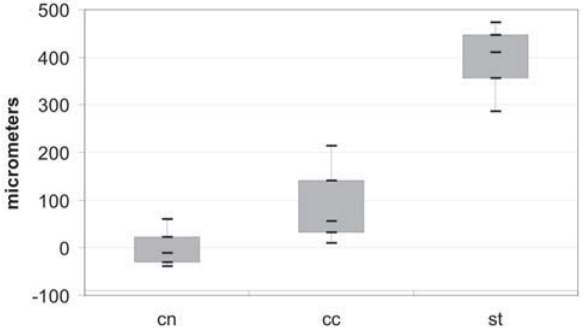
FIGURE 2- Box-plot of data expressed in µ m. cn – acrylic copings without cervical contact; cc – acrylic copings with cervical contact; st – stock perforated